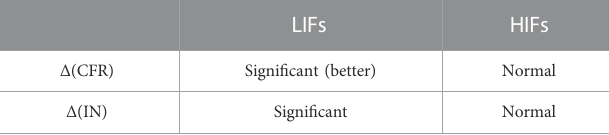
TABLE 3 Comparison of the effectiveness of different technologies for monitoring